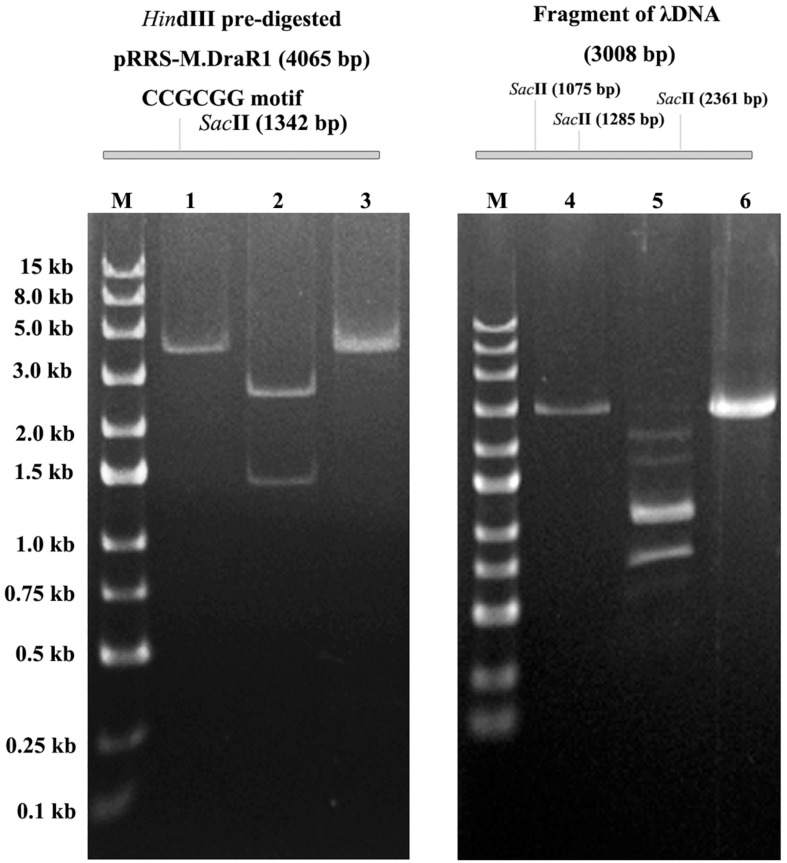
In vitro methyltransferase activity assay of the purified M.DraR1. PCR amplified pRRS-M.DraR1 vector was linearized by HindIII (lane 1), and then purified and methylated with M.DraR1 enzyme in vitro. Methylation of the plasmid prevented it digestion by SacII (lane 3) in contrast to un-methylated control one (lane 2). The methylation of PCR amplified λDNA fragment containing three “CCGCGG” sites (lane 4) with M.DraR1 protected it from being digested (lane 6) by SacII as well. Lane 5 is the unmethylated λDNA fragment. M, 250 bp DNA ladder (TSJ105-100) from Beijing TsingKe Biotech Co., Ltd. All experiments were performed in three independent biological replicates.